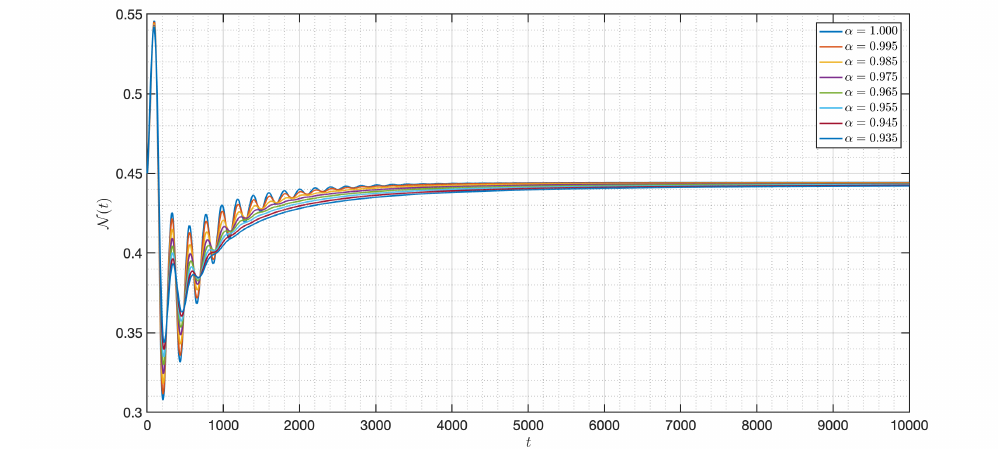
Figure 34. Dynamic of the model (3) for different parameters in Case IV with α = 1.000.